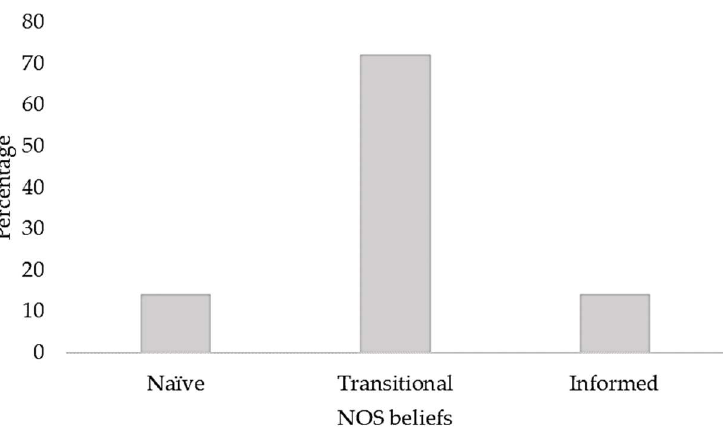
Figure 1. Distribution of the participants’ NOS beliefs according to their respective SUSSI score.